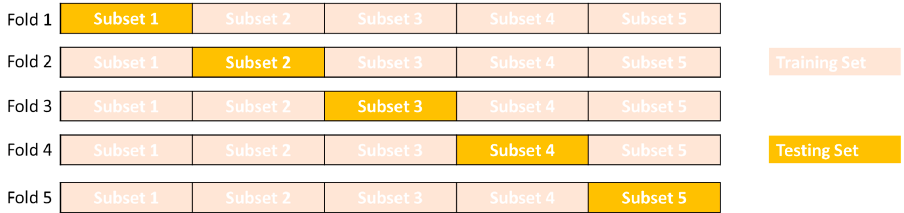
Figure 4. This figure demonstrates data splitting in 5-fold cross-validation.